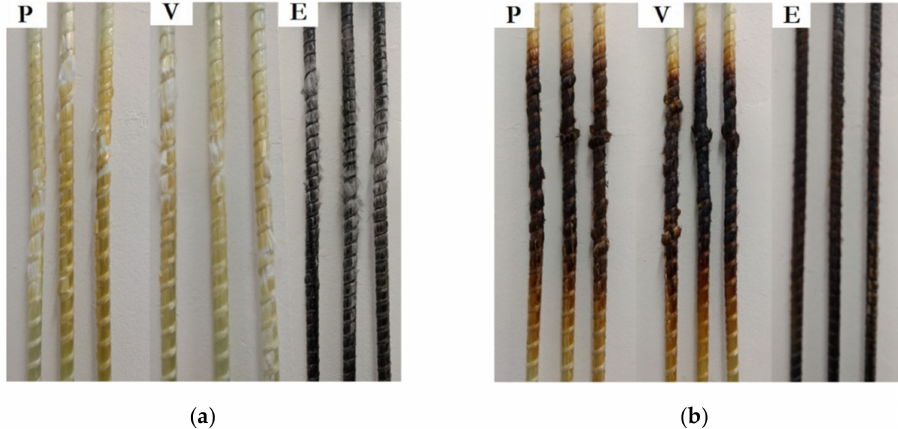
Figure 8. Failure modes of GFRP bars tested at temperatures of ( a ) 150 ◦ C, and ( b ) 300 ◦ C.